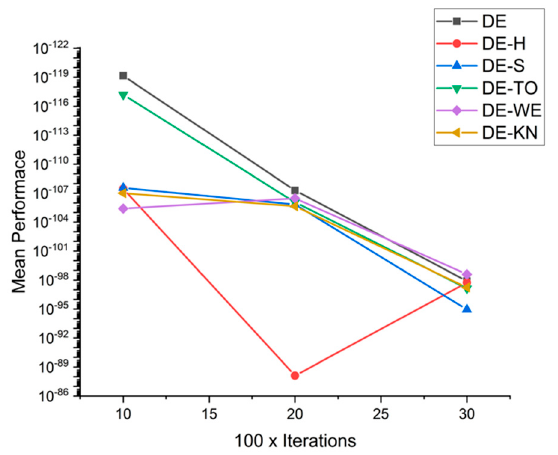
Figure 29. Convergence curve on fn7.